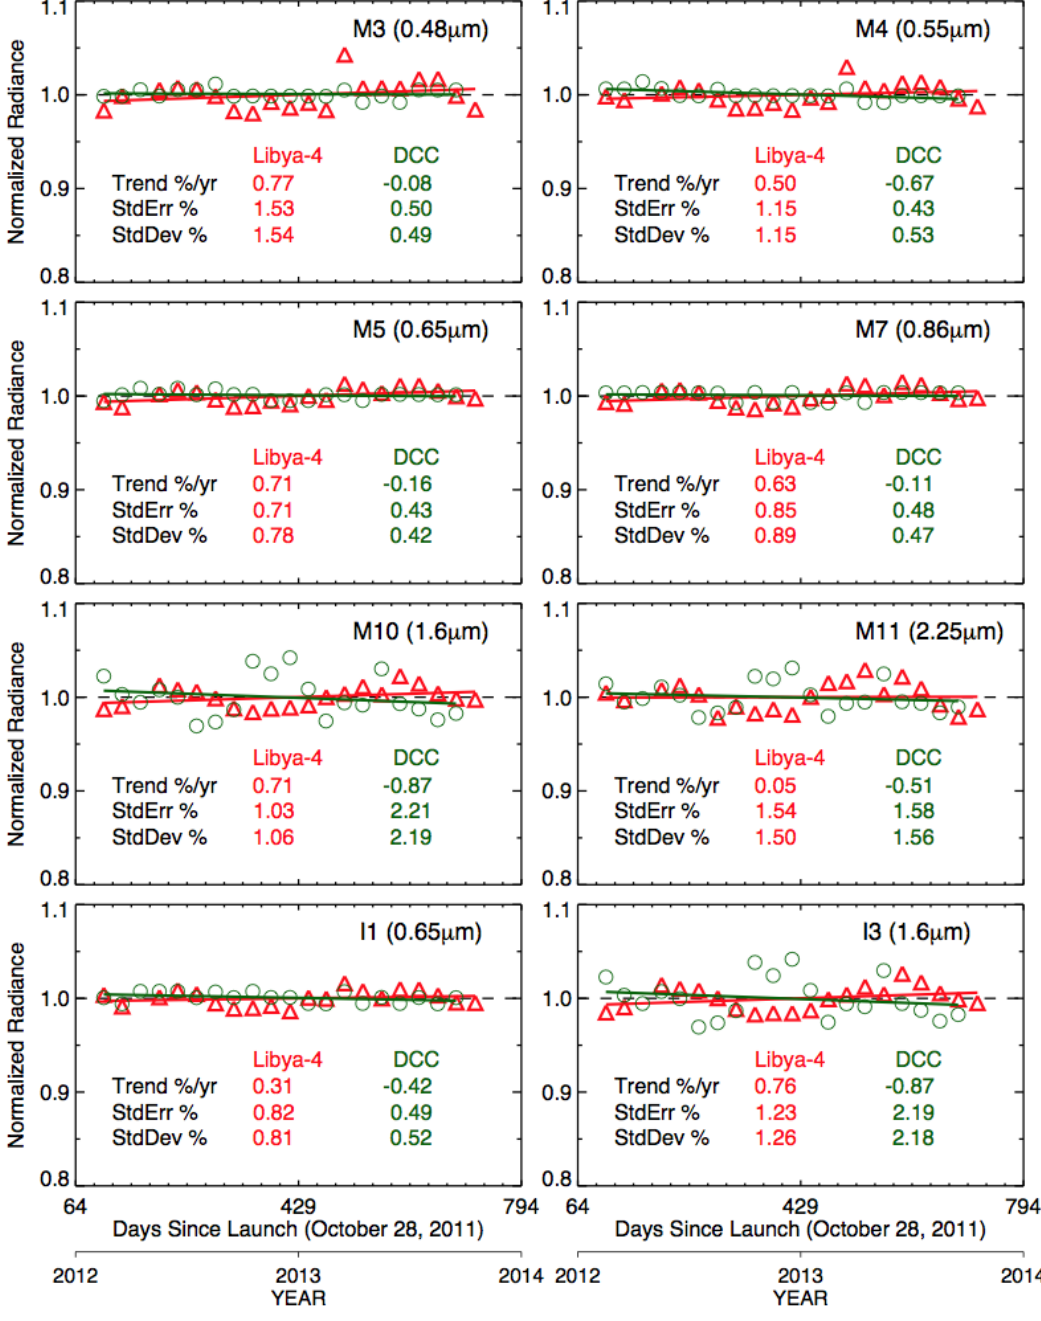
Figure 4. The normalized desert and DCC responses time-series for VIIRS RSB during the 2012–2013 time